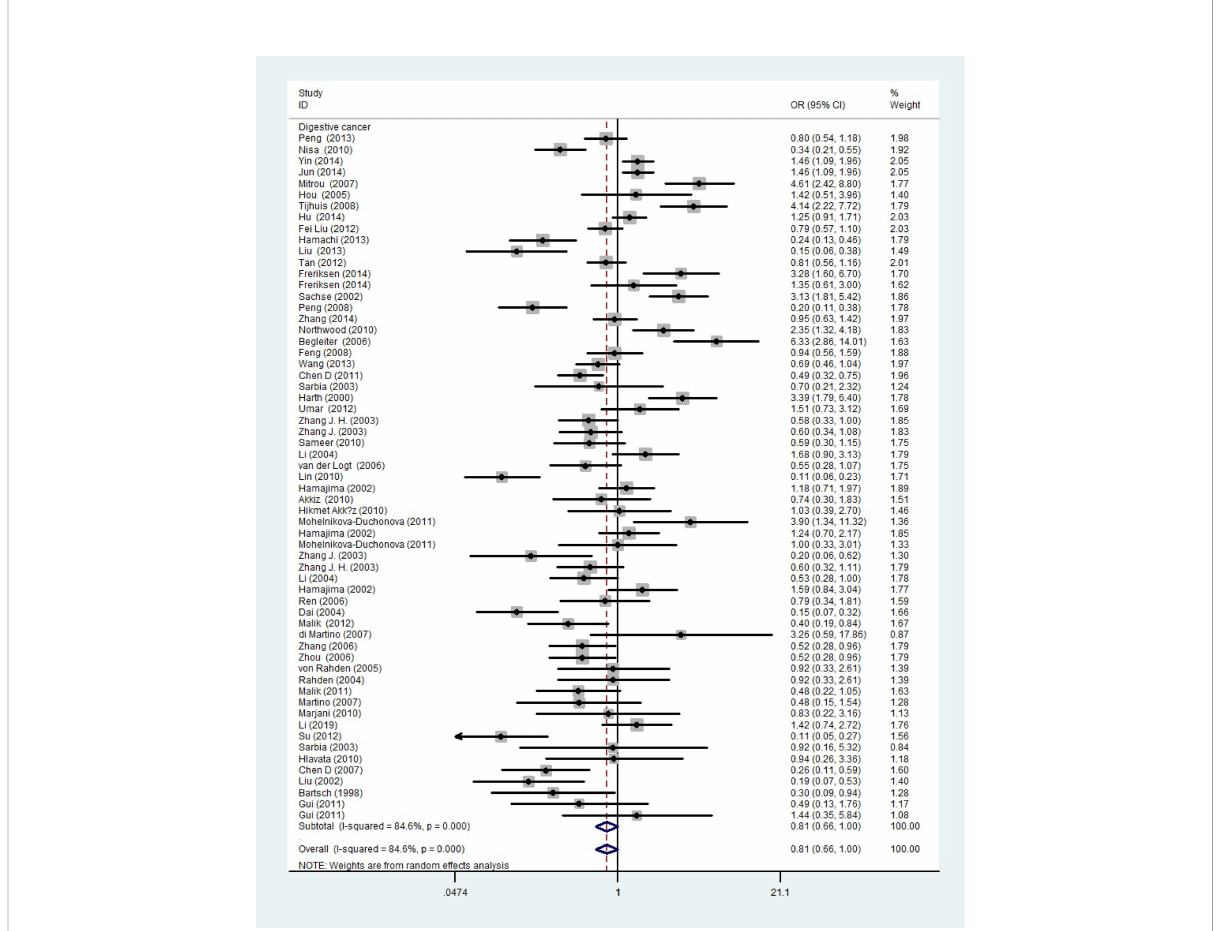
FIGURE 4 A forest plot showing the relationship between the NQO1 gene ’ s rs1800566 polymorphism and digestive cancer. There were signi fi cantly decreased association between NQO1 polymorphism and digestive cancer. The squares and horizontal lines correspond to the study-speci fi c OR and 95% CI. The area of the squares re fl ects the weight (inverse of the variance). The diamond represents the summary OR and 95%